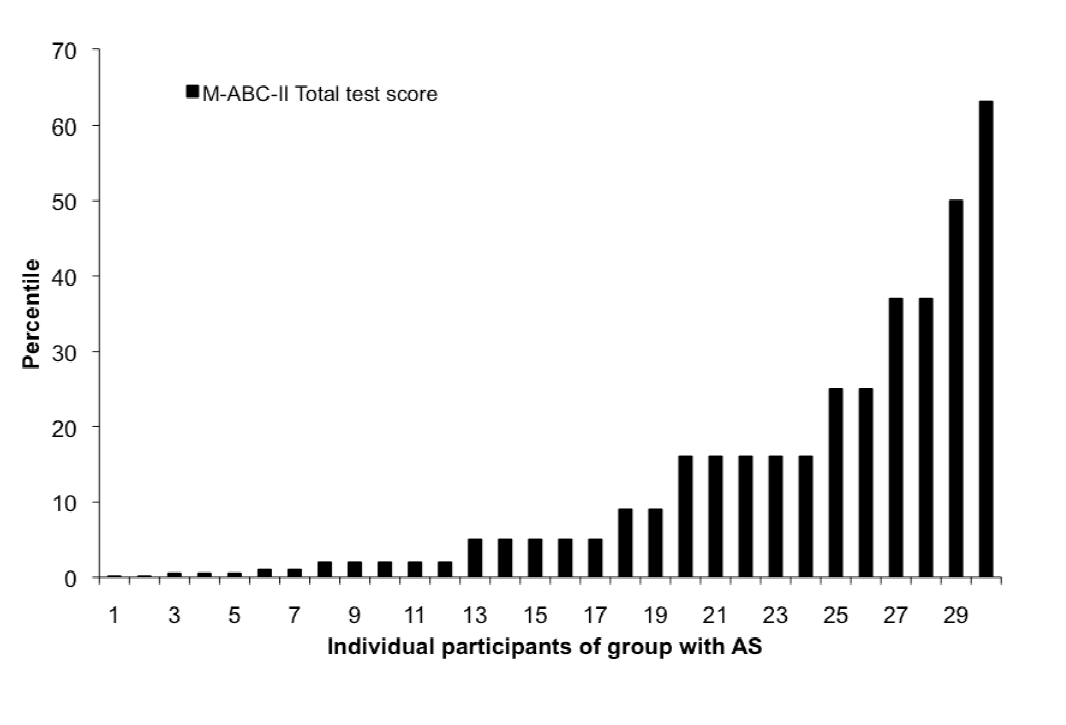
Figure 2. Percentile equivalents for M-ABC-II total test score for group with AS (N =